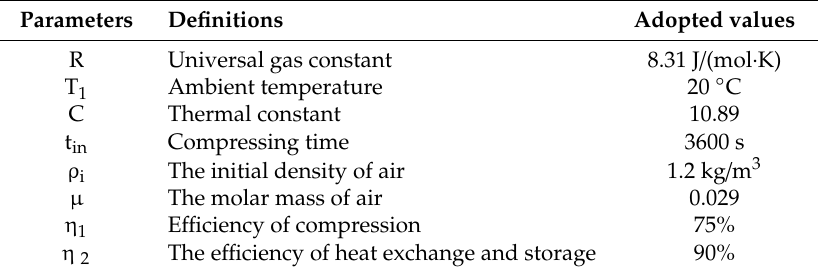
Table 1. Parameters in the thermodynamic